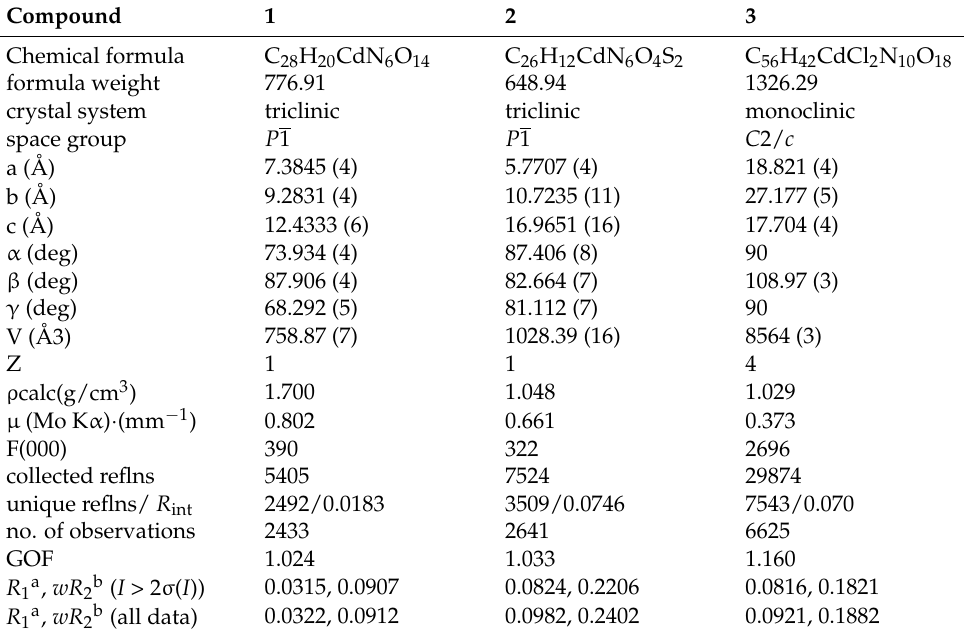
Table 1. Crystallographic data and structure refinement details for 1 − 3